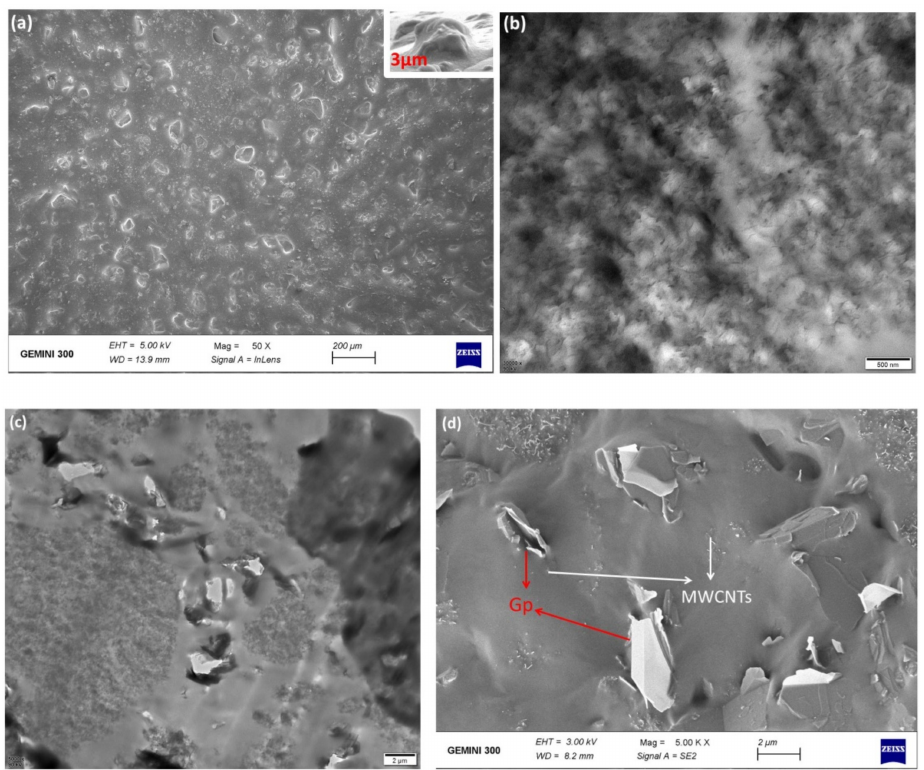
Figure 3. ( a ) SEM image of the top substrate on a scale of 200 µ m and 3 µ m. ( b ) TEM image of the 5%MWCNTs@5%Gp film on the scale of 500 nm. ( c ) TEM image of the 5%MWCNTs@5%Gp film on a scale of 2 µ m. ( d ) SEM image of the 5%MWCNTs@5%Gp film on a scale of 2 µ